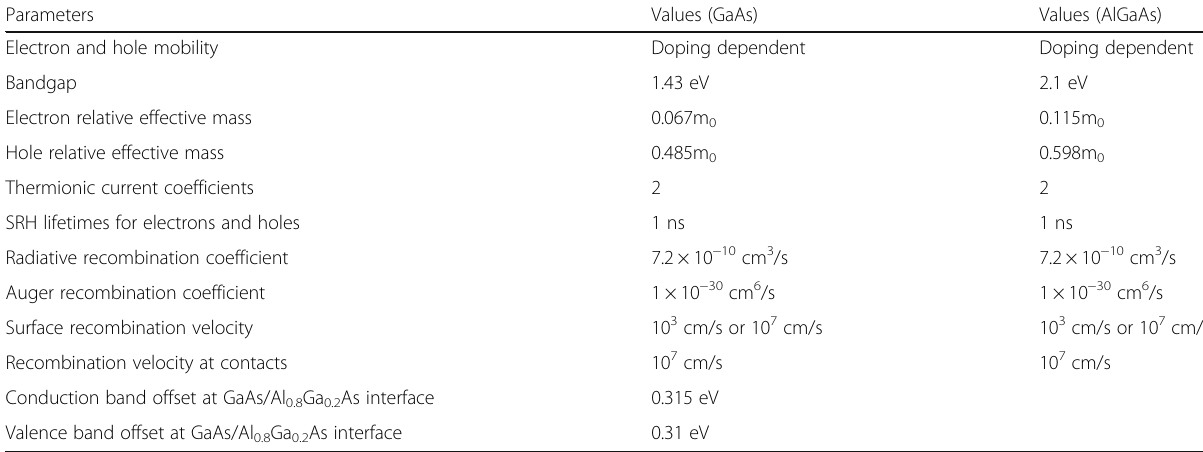
Table 1 Key simulation